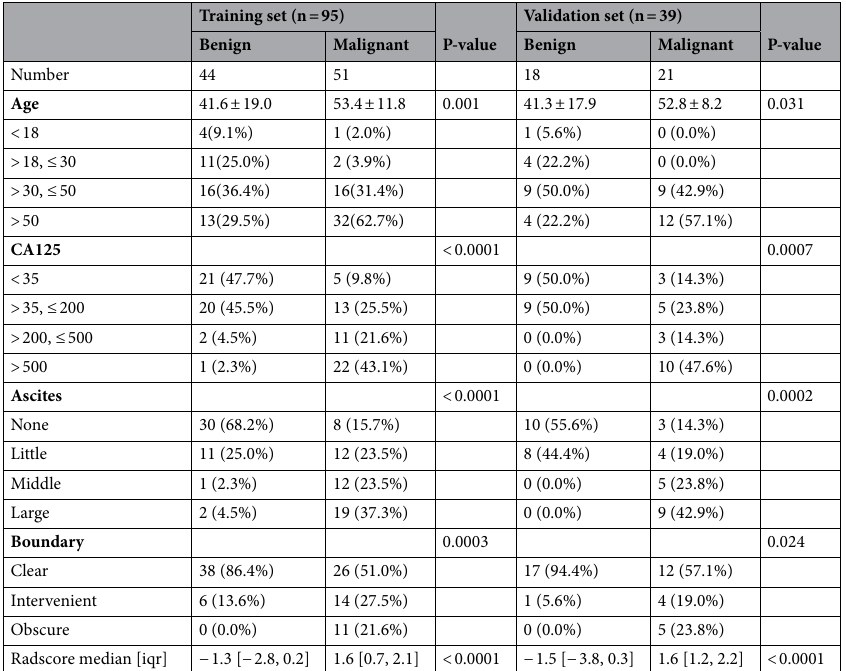
Table 1. Demographic characteristics in the training and validation sets.